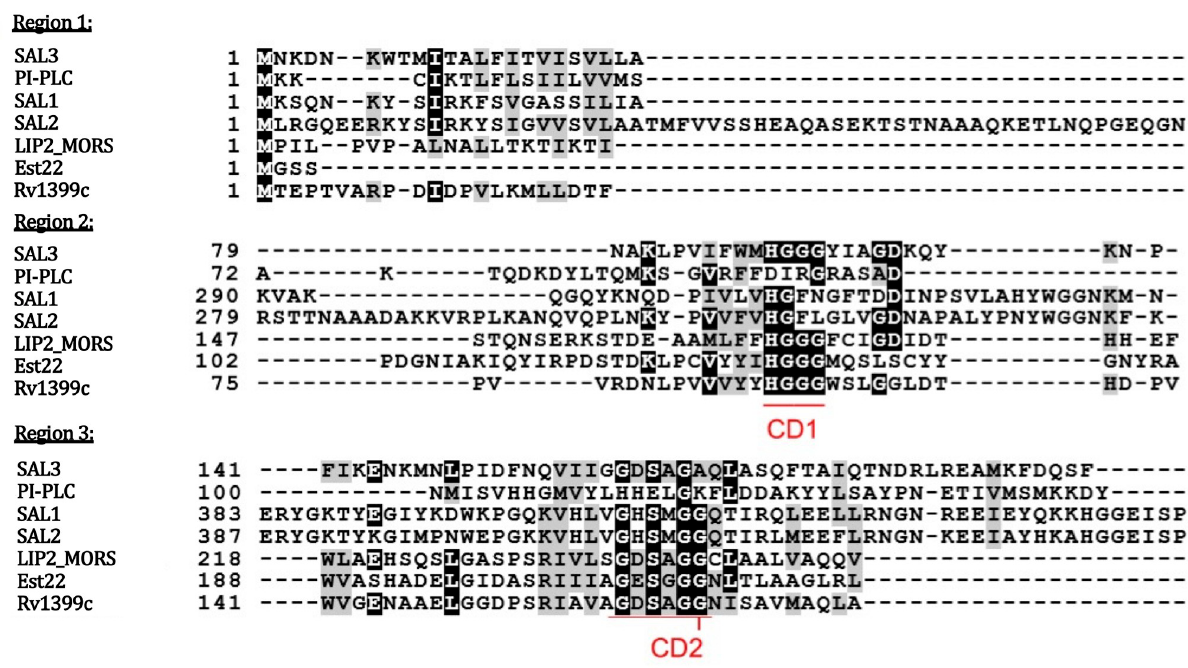
Fig 1. Multiple sequence alignment of SAL3. Multiple sequence alignment of SAL3 (SAUSA300_0641) with other characterized lipases of S . aureus (PI-PLC, SAL1(SAUSA300_2603), SAL2(SAUSA300_0320)) and bacterial esterase Lip2_MORS1 ( Moraxella ), Est22 (Deep sea isolate), Rv1399c ( Mycobacterium tuberculosis